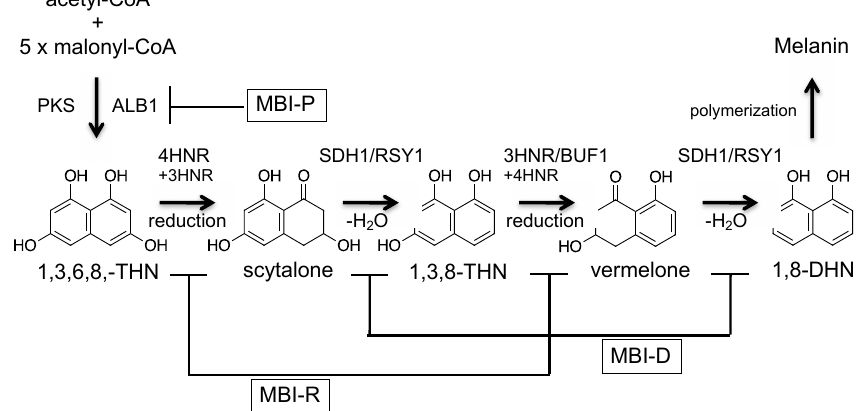
Figure 2. Melanin biosynthetic pathway of the rice blast fungus P. oryzae .